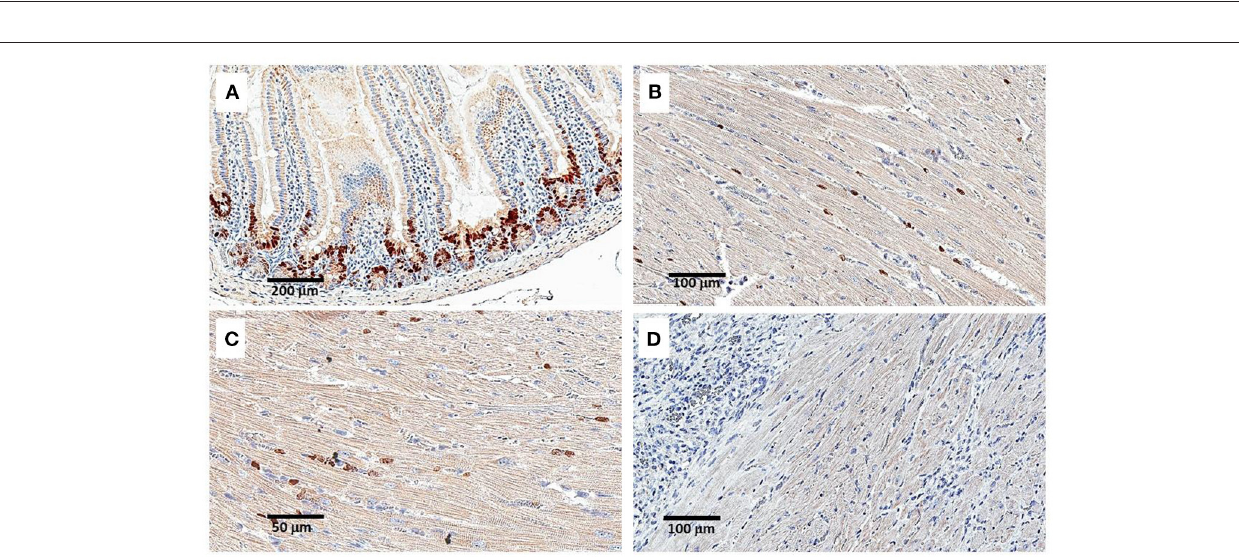
FIGURE 5 | upper image of each pair is stained with H&E (arrows indicate areas of macrophage infiltration); lower image is stained with Trichrome (areas debrided of cardiomyocytes are stained gray). (A) One representative saline control at each of 3 time points post-MI. (B) One representative α -gal nanoparticles treated animal at each time point. The arrows mark macrophages infiltrating areas. Note on Day 4, arrows mark the macrophages at the two nanoparticles injection sites. (C) Planimetry of injured myocardium as percent of LV relative to the area of uninjured LV in two hearts per time-point. Open-columns: saline control: closed-columns: α -gal nanoparticles treatment. (D) Quantification of infiltrating macrophages within injured myocardium (H&E), columns as in (C) . (E) Staining of the infiltrating cells into heart injected with α -gal nanoparticles and viewed on Day 7 post-MI (H&E). (F) Cells in (E) are macrophages as they stain with peroxidase coupled anti-F4/80 antibody, an antibody that binds specifically to macrophages (Representative of three hearts with similar results). (G) Demonstration of the full overlap between the area with infiltrating macrophages (H&E staining) and the corresponding area debrided of injured cardiomyocytes (Trichrome staining). The sections to the left and right of the middle section (also shown at Day 7, B ) are 300 µ m above and below the middle section, respectively. The full overlap between areas of macrophages and debrided areas strongly suggests that the macrophages debride the damaged cardiomyocytes in the areas they reside.